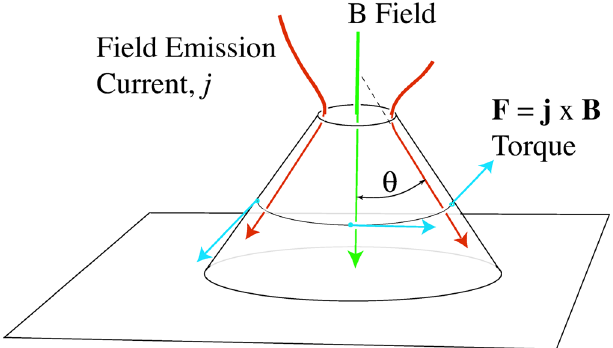
FIG. 4. (Color) Forces due to field emission currents are present in the field emitters.